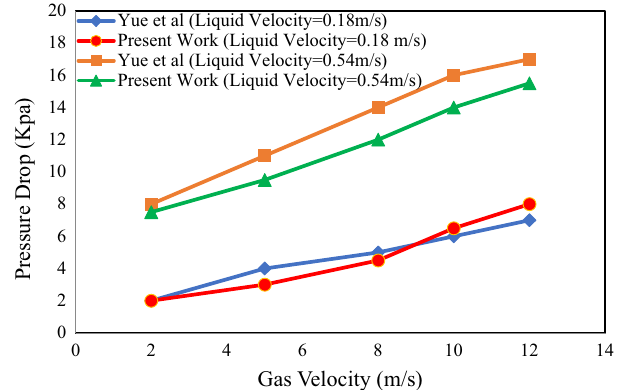
Figure 2. Pressure drop of gas liquid two phase flow versus